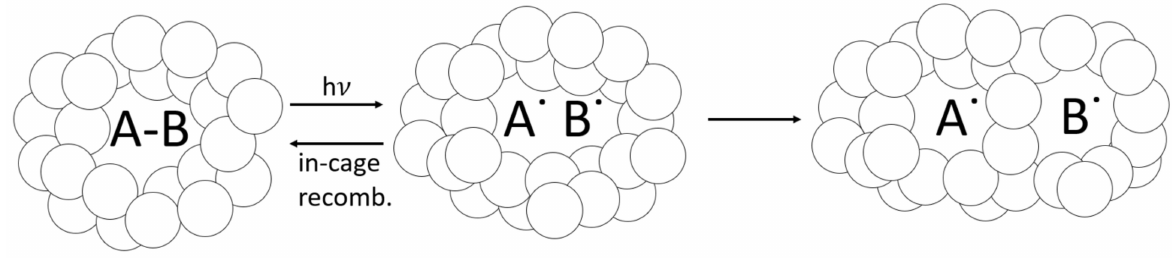
Figure 12. Cage effect, which can apply to occluded PI molecules. As PI absorbs light and reacts, its reaction byproducts can become trapped within the tightly packed vitrified-polymer network, which will either recombine or dissociate. Some free radicals can still react via diffusion, even in the glassy polymer.